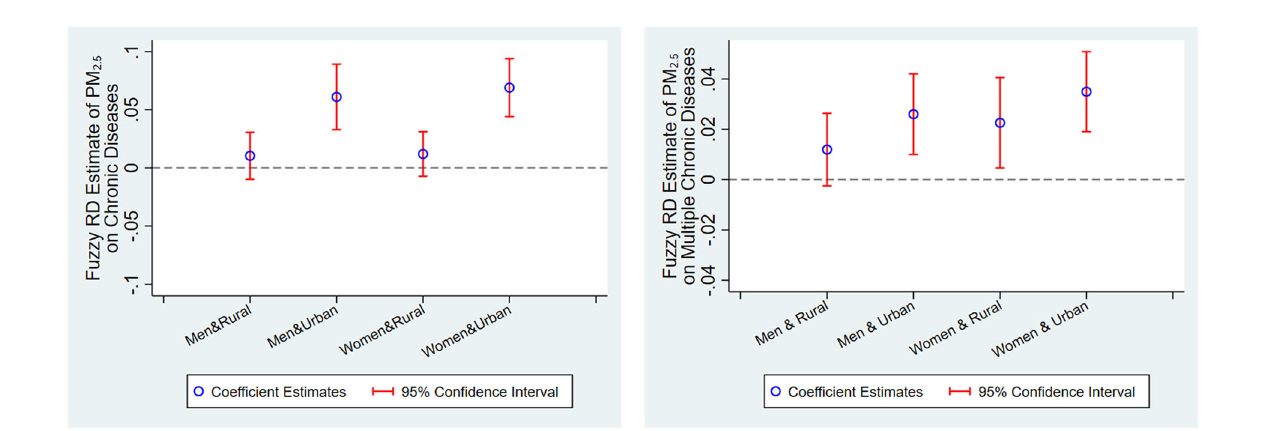
FIGURE4 Heterogeneous effect of additional 10 µ g/m 3 exposure to PM 2.5 on chronic diseases by gender and urban/rural status. These graphs present fuzzy RD nonparametric point estimates of the effect of additional 10 µ g/m 3 exposure to PM 2.5 on chronic and multiple chronic diseases, regarding distance from the Huai River as the running variable and PM 2.5 as the treatment variable, with the Huai River representing a “fuzzy” discontinuity at the level of pollution exposure by gender and urban/rural status and the associated 95% confidence intervals. The discontinuities are estimated using a triangle kernel local linear regression and the optimal bandwidth is chosen by the common MSE-optimal bandwidth selector. Each point estimate includes all the covariates, other than gender and urban/rural status, listed in Table